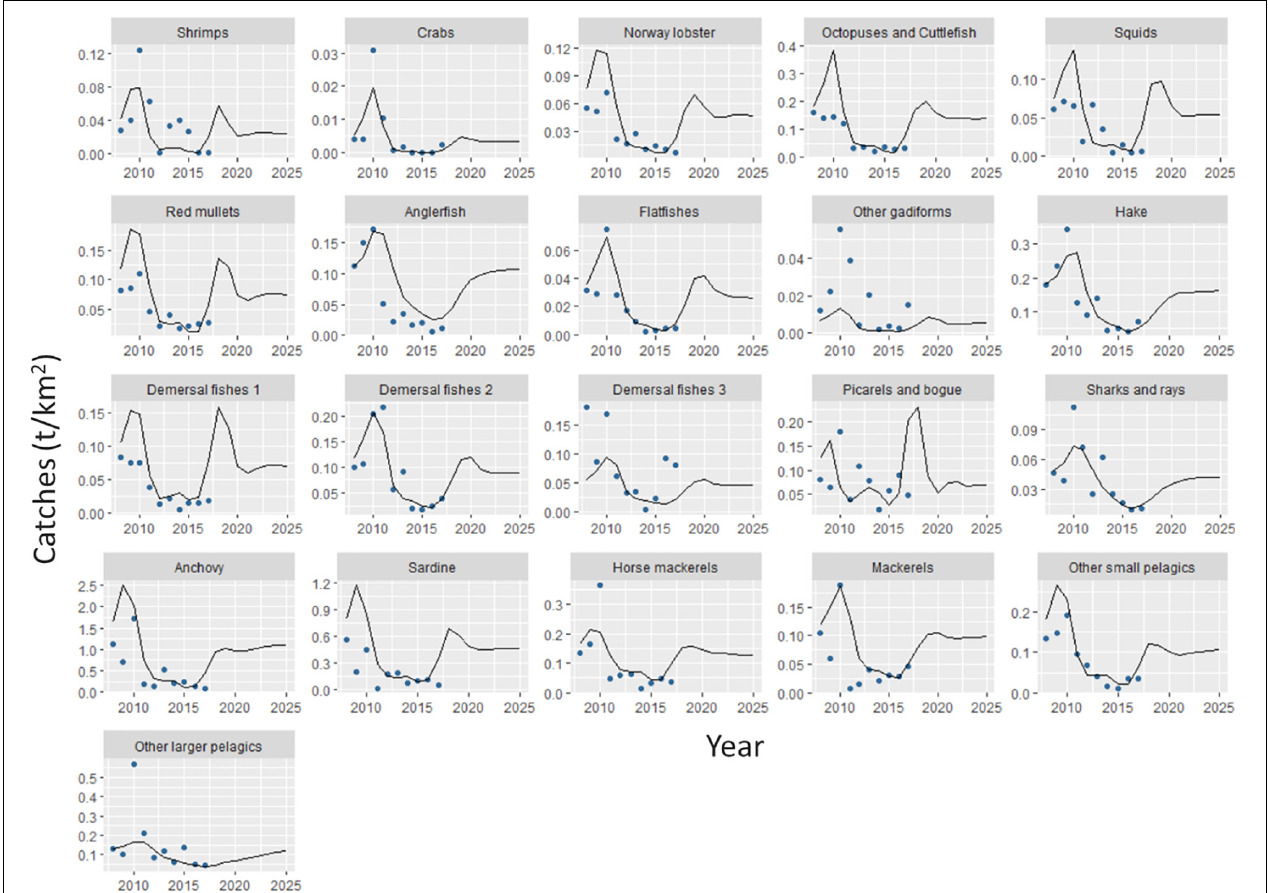
FIGURE 6 | Catches predicted by the Ecosim model (lines) for each functional group of Pagasitikos Gulf from 2008 to 2025, in comparison to reconstructed official catches (points) (based on Moutopoulos and Stergiou, 2012).